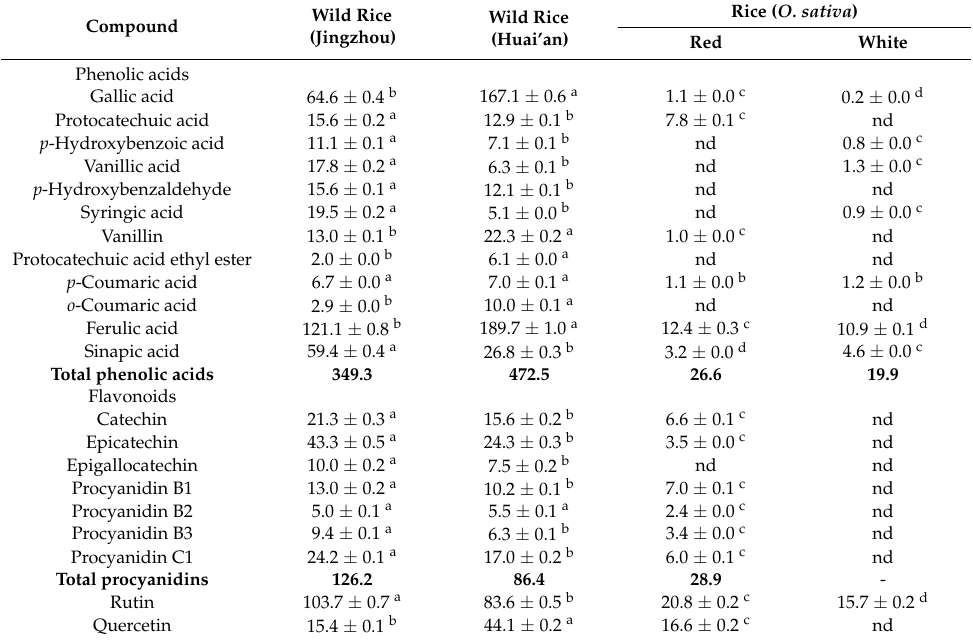
Values are mean ± standard error ( n = 5). Values with different letters in the same row indicate significant differences ( p < 0.05). nd, not